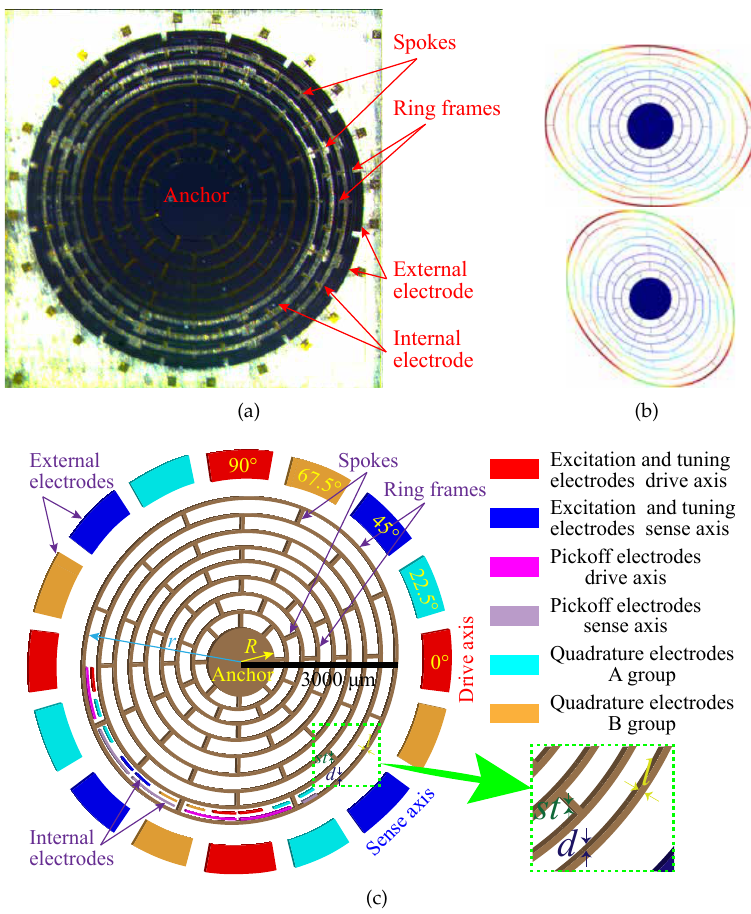
Figure 1. Microscope image, mode shapes and microstructure schematic of DRG: ( a ) microscope images of DRG; ( b ) mode shapes of the n = 2 wine-glass modes of DRG; ( c ) the 3D schematic of the microstructure of the